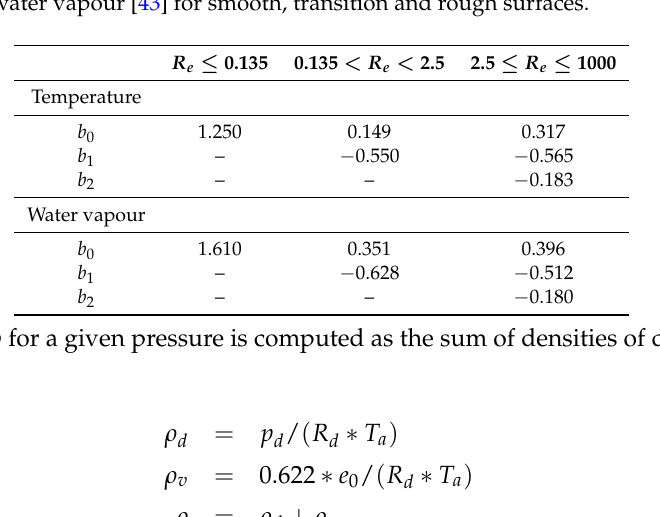
Table A1. Values of the coefficients in the polynomials (Equation (A18)) that predict z 0 / z for temperature and water vapour [43] for smooth, transition and rough